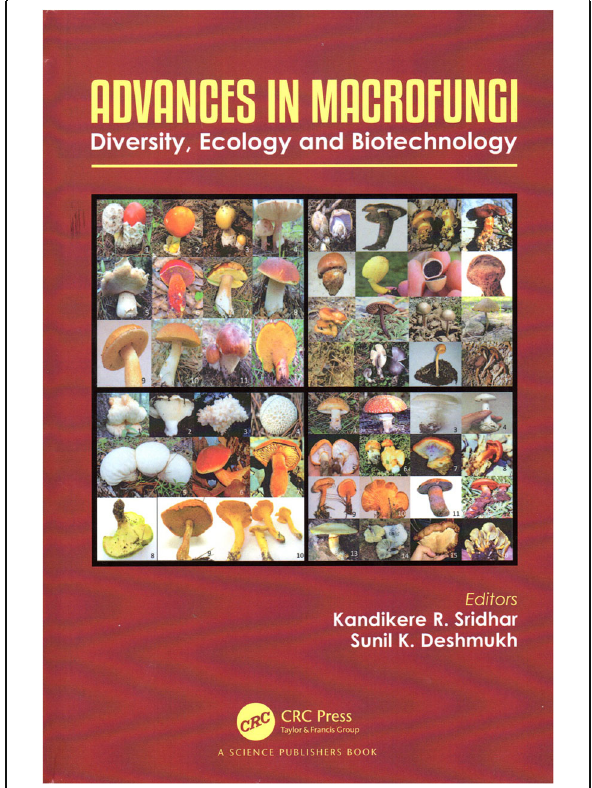
Fig. 22 Advances in Macrofungi: diversity, ecology and biotechnology